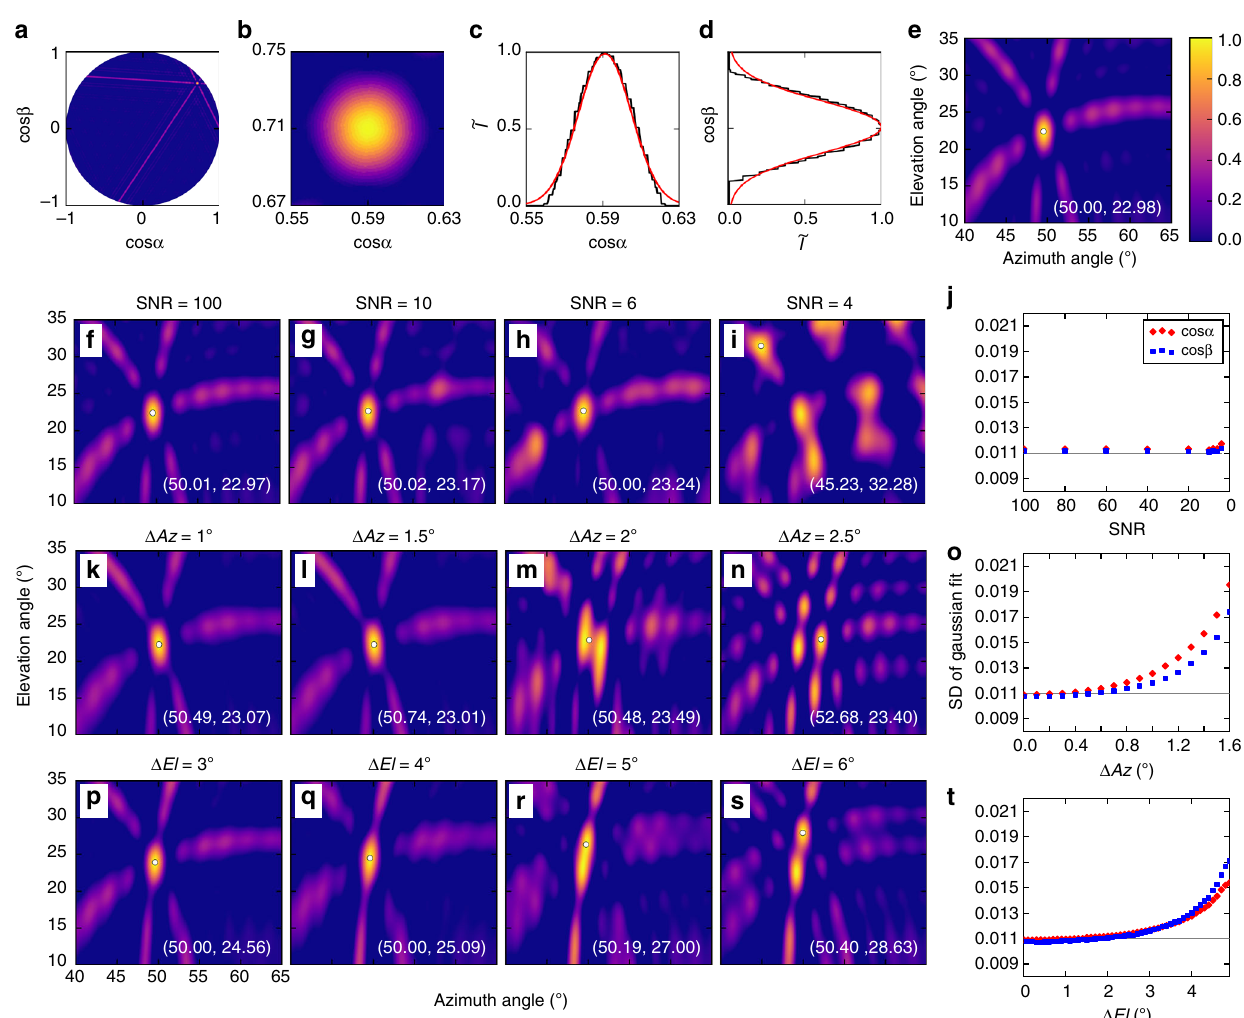
Fig. 7 Radio images of different source types. Simulated images and related information of: a – e an ideal point source, corresponding to the point spread function (PSF) of the antenna array, f – j the effect of uncorrelated noise on the observations, and the effect of angular separation of two equal-power point sources in azimuth ( k – o ), and elevation ( p – t ). Each image shows the normalized intensity ð ~ I Þ of a 0.7- μ s exposure of sources at the location of NBE 2. Panels c and d show that the central lobe of the PSF has a standard deviation (SD) of 0.011 in both the cos α and cos β directions, corresponding to SDs of 1.6° and 3.8° in azimuth and elevation, respectively. As seen in j , added noise has little effect on the size of the central lobe, remaining close to the PSF value of 0.011 (horizontal gray line) for signal-to-noise ratios down to 6. Binary sources have a much stronger effect, with the two sources being readily distinguishable for azimuthal separations of 2° or elevation separations of 5 – 6°. The fi xed central lobe becomes noticeably deformed well before